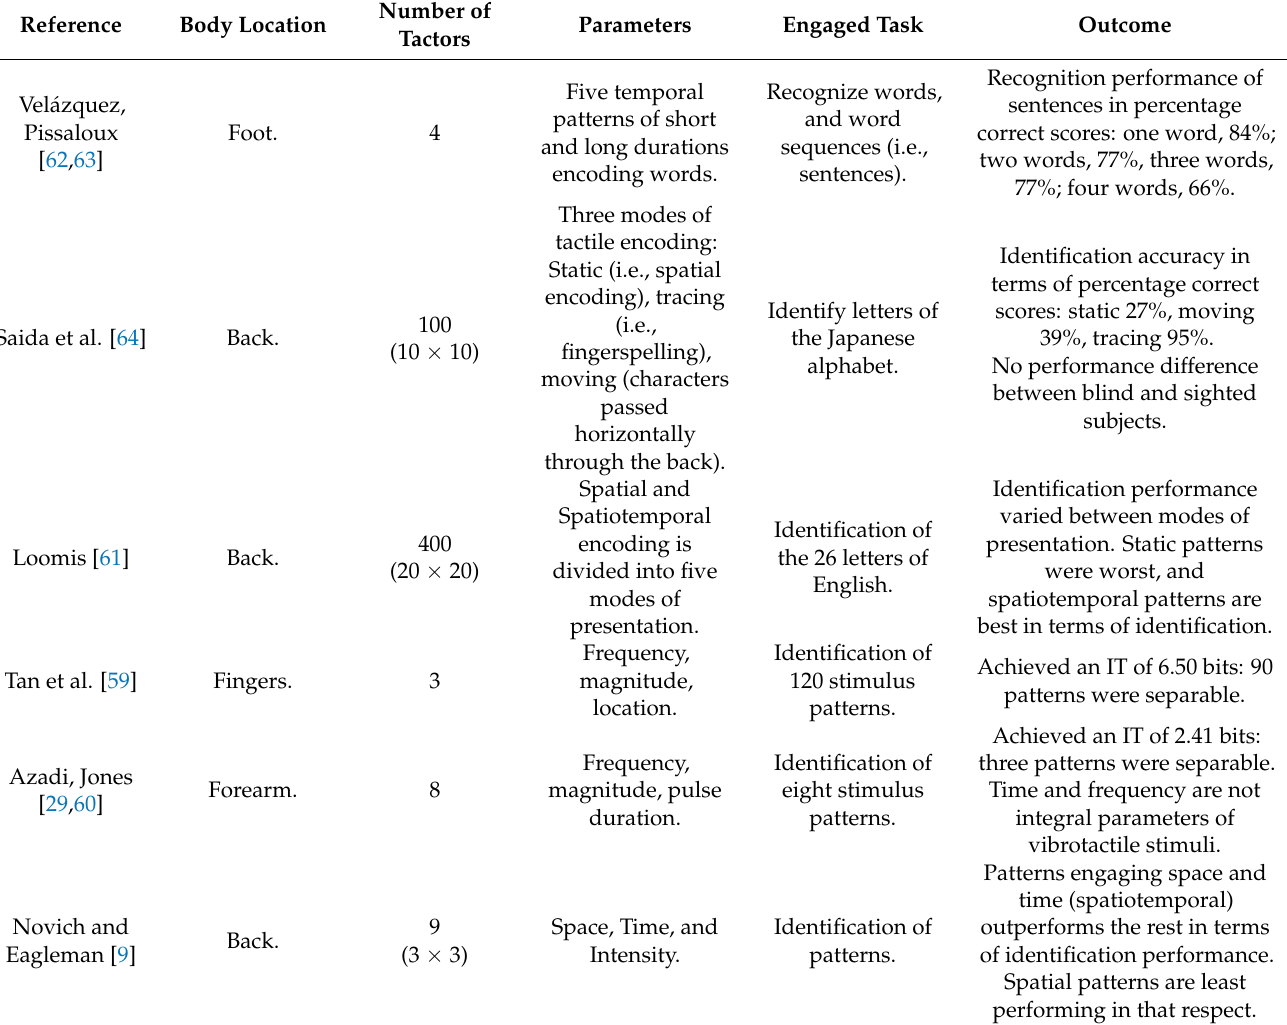
Table 2. Methods for designing tactile patterns without